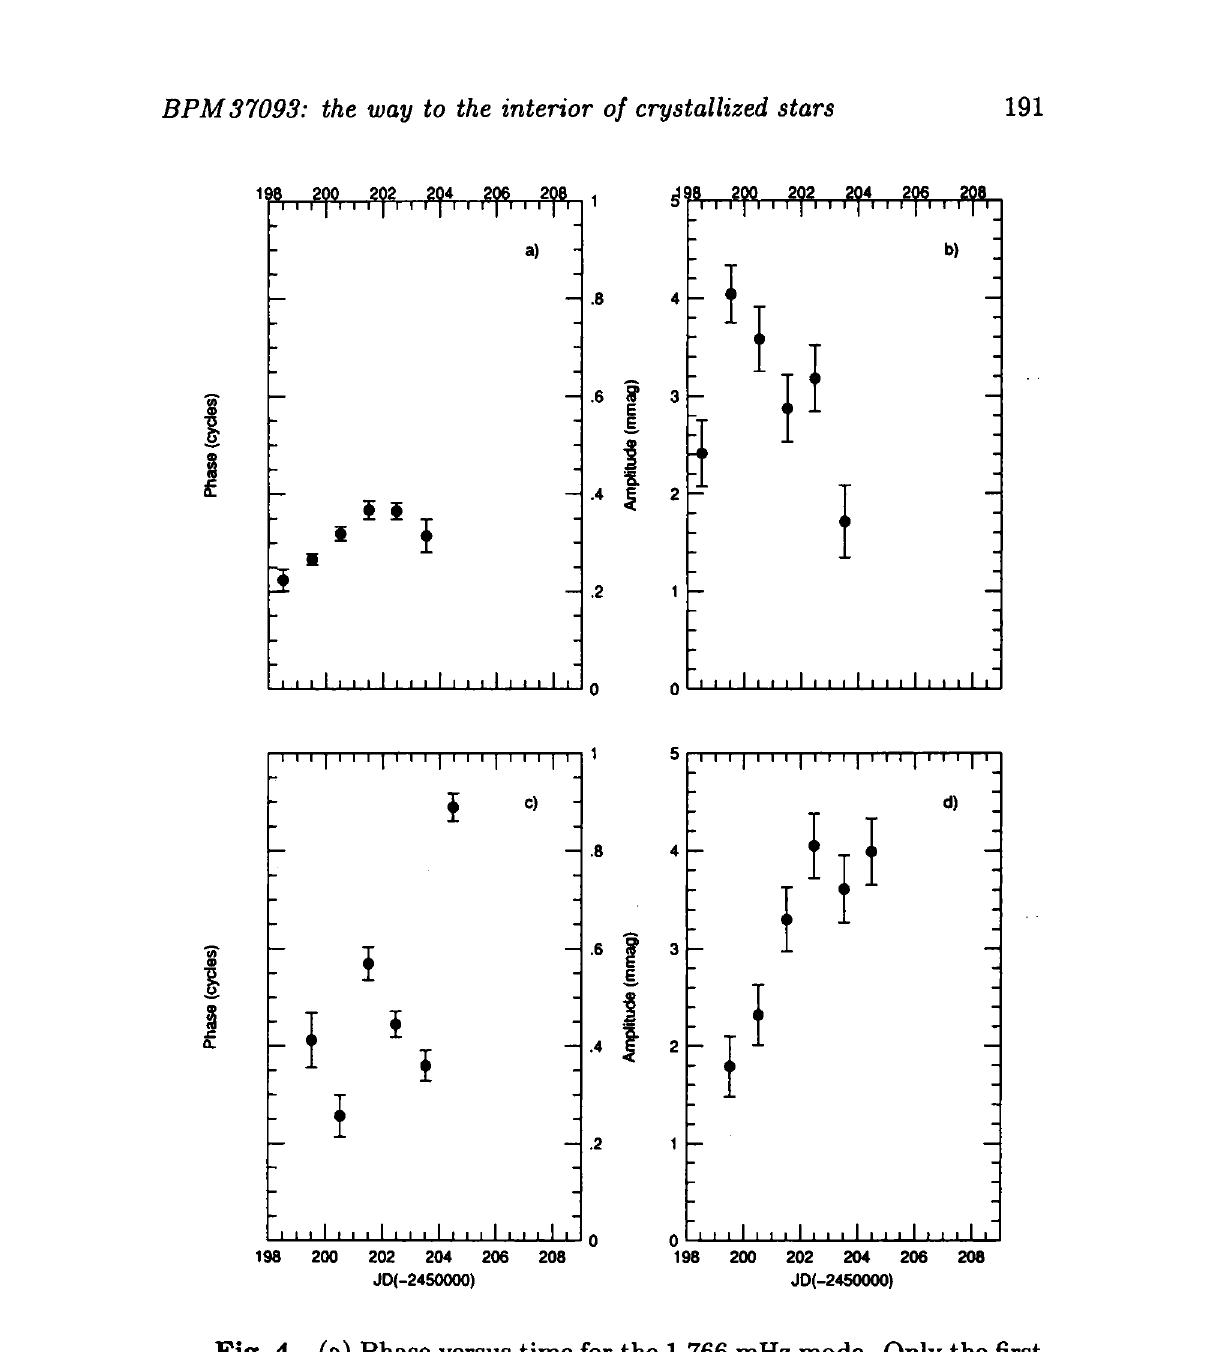
Fig. 4. (a) Phase versus time for the 1.766 mHz mode. Only the first six nights are on this plot because this mode disappears in the last four nights, (b) Amplitude versus time for the 1.766 mHz mode, (c) Phase versus time for the 1.716 mHz mode. We have plotted data from the second night till the seventh. For other nights this mode was not present, (d) Amplitude versus time for the 1.716 mHz